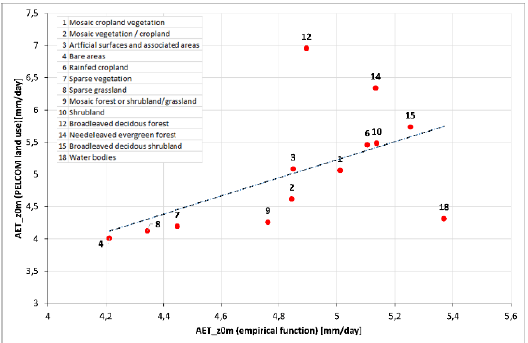
Figure 9. Scatter plot of AET estimated using separately the two approaches (empirical function and land cover classification) to determine roughness height for momentum transfer and aggregated by land cover in Medjerda basin on May 6, 2010.